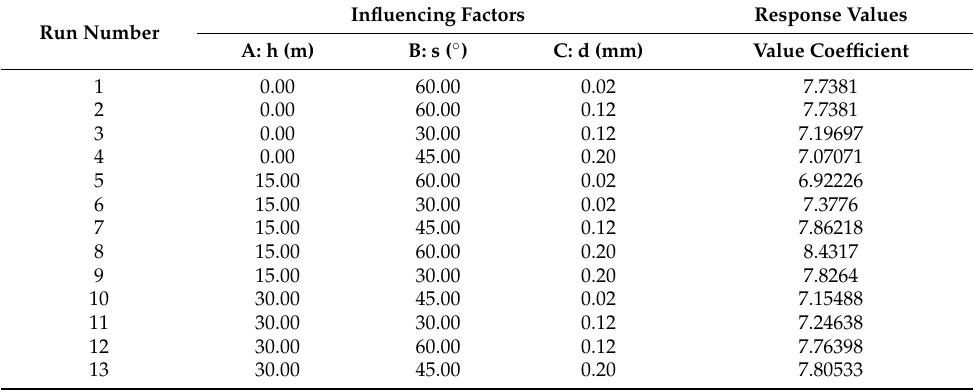
Table 4. Calculation table of value coefficients.